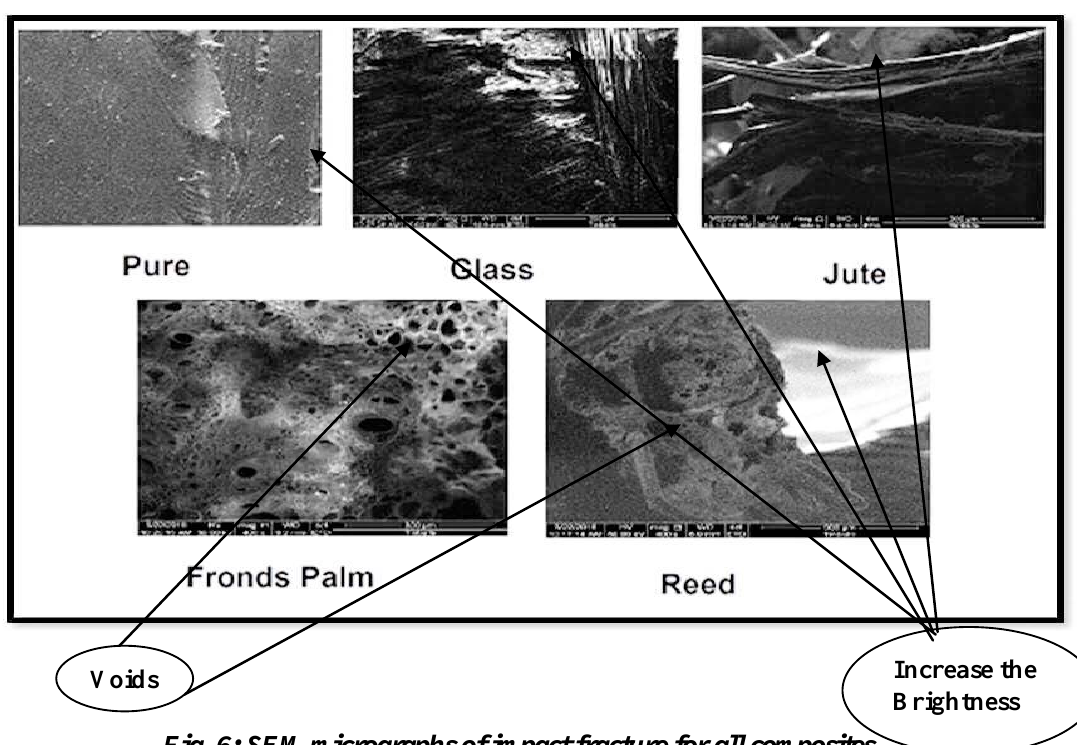
Fig. 6: SEM micrographs of impact fracture for all composites.